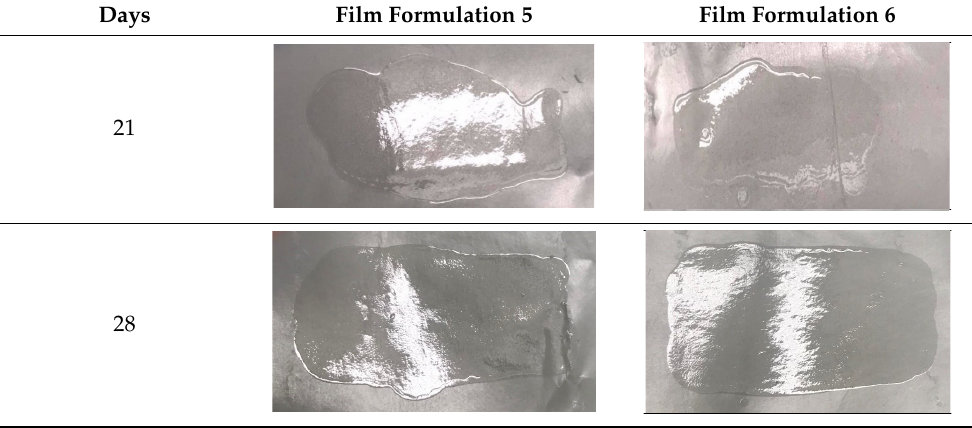
Table 5. Status of the control and non-control gels formulation before and after the stability study.